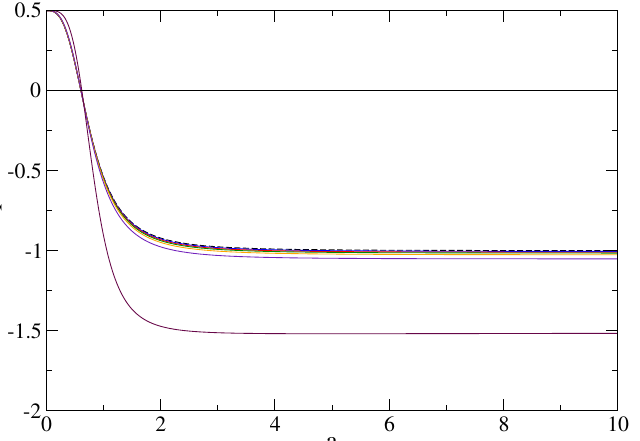
Figure 5. Deceleration parameter q as a function of the scale factor a for Ω m ,0 = 0.309, B = 3.53 × 10 − 3 and n = 0,1,2,3,5,10,100.